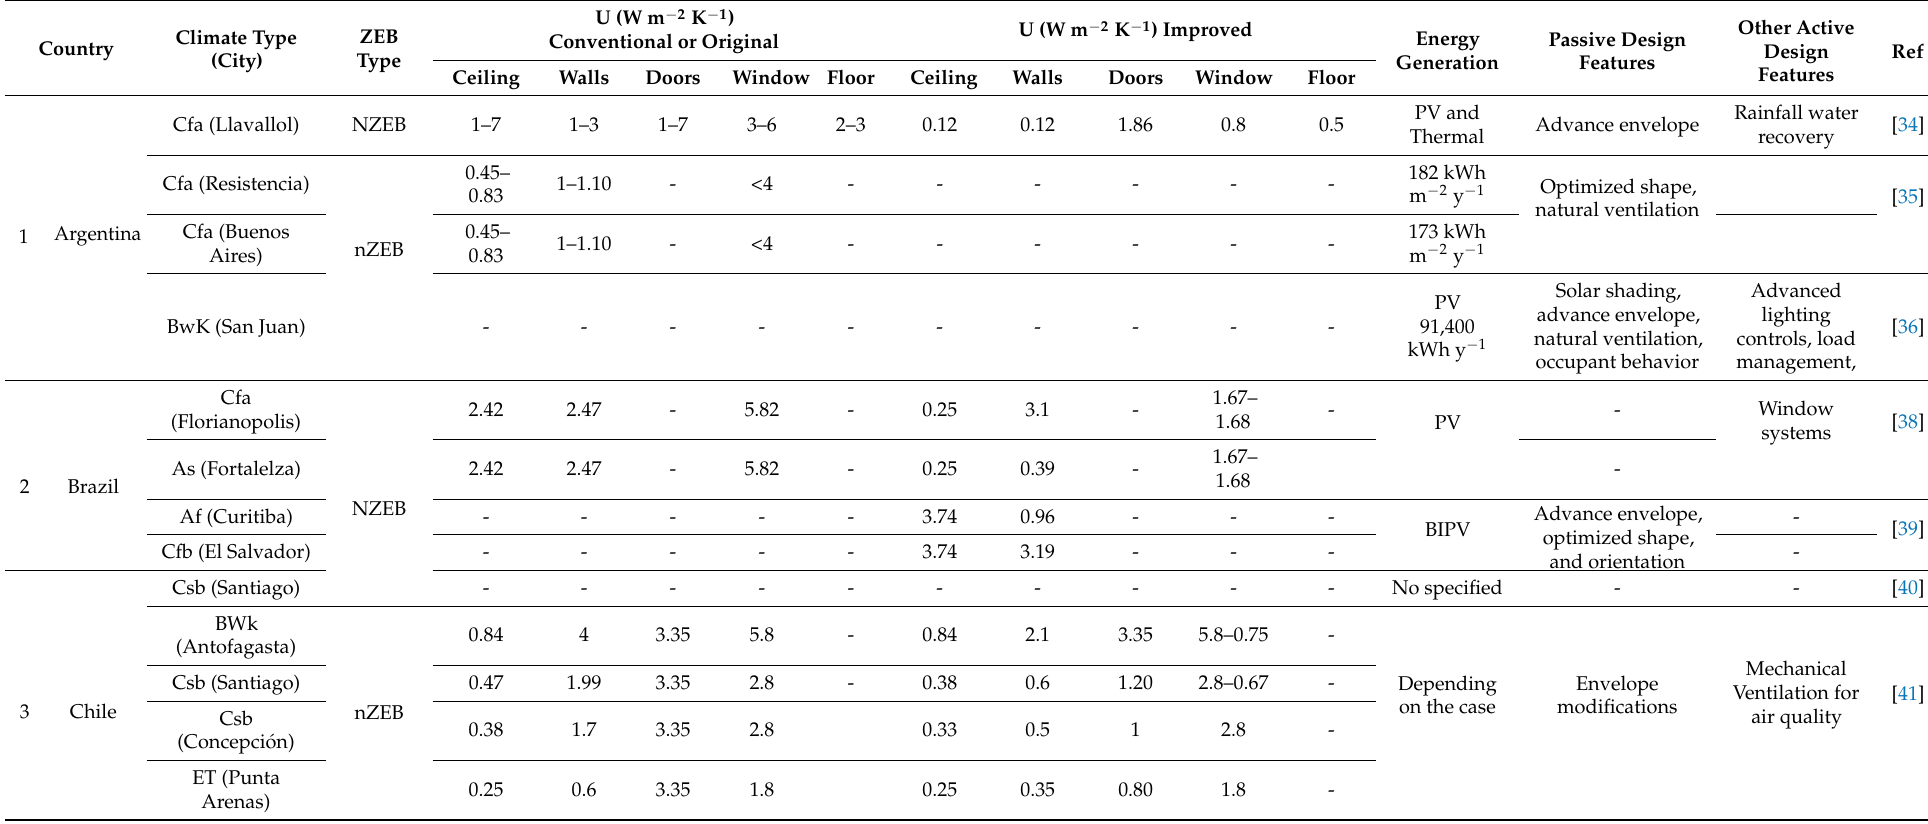
Table 3. Countries in Latin America U-values and energy